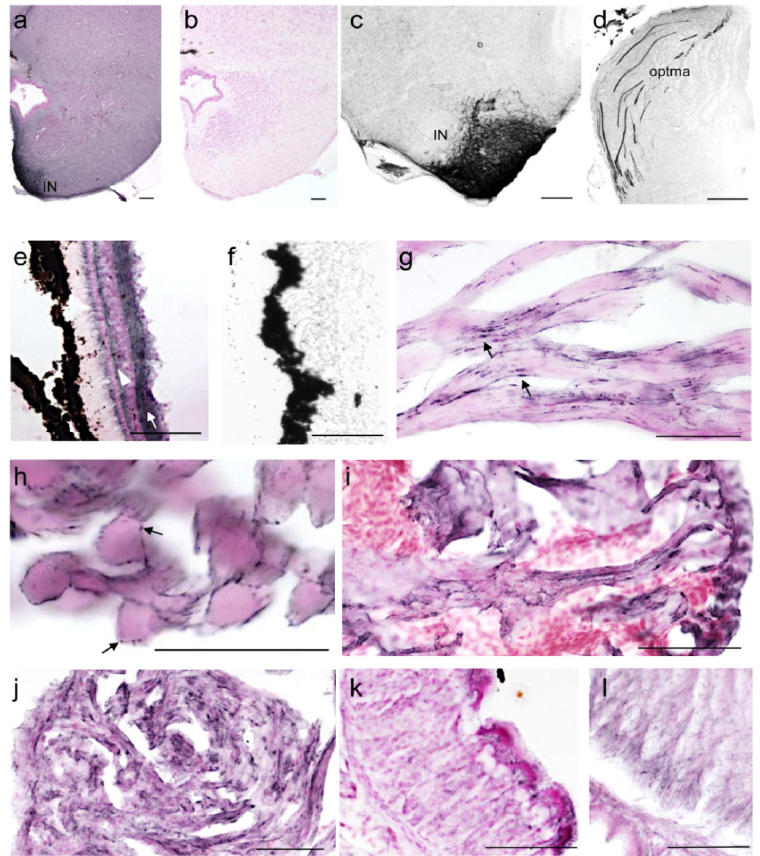
Figure 5. Immunohistochemical analysis of the α -syn distribution. Xenopus brain coronal sections ( a – d ). Strong α -syn immunoreactivity was found in the interpeduncular nucleus ( a , c ) and in the visual projections, tractus opticus marginalis ( d ). Retina ( e , f ). The strongest α -syn immunoreactivity was found in the thick inner plexiform layer (white arrow) and in the outer plexiform layer (white arrowhead) ( e ). No immunoreactivity was found in control sections ( b , f ). The α -syn immunoreactivity was found in motor nerve endings within skeletal muscle (longitudinal ( g ), and transverse section ( h ), arrows) and heart muscle ( i , j ). α -syn immunolabelled nerve fibres were found also within all layers of the stomach wall ( k , l ). Some sections have been counterstained with Nuclear Fast Red Solution. IN: interpeduncular nucleus ; optma: tractus opticus marginalis . Bar = 100 µm.